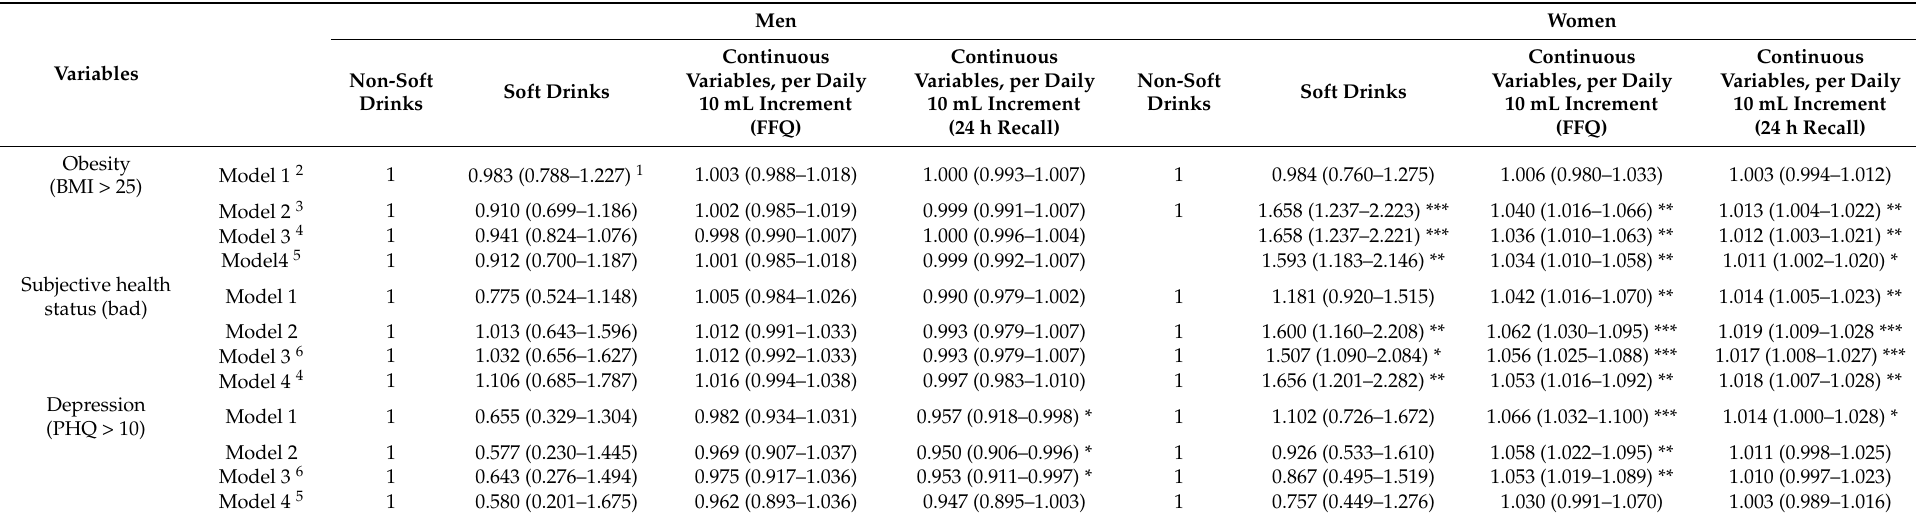
Table 4. ORs for health-related outcomes by soft drink